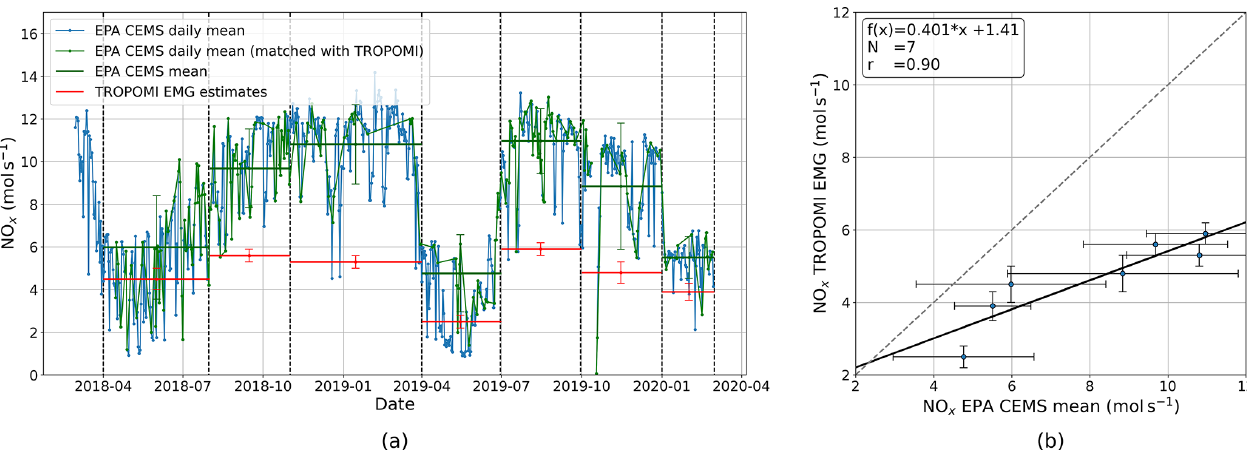
Figure 4. (a) CEMS NO x emissions for the Colstrip (Montana, USA) power plant compared to the NO x emissions estimated by the EMG method, using TROPOMI NO 2 data. CEMS data are daily mean values, averaged between 11:00 and 14:00 local time, shown in blue and filtered for days with TROPOMI measurements shown in green. Means over seven selected periods, marked by the dashed black lines, are shown by the horizontal green lines for the CEMS data and red lines for the TROPOMI EMG estimates. (b) Scatter plot of CEMS-measured NO x emissions versus TROPOMI EMG NO x emission estimates for the seven periods. The 1 : 1 line is indicated with the gray dashed line. The solid black line indicates the linear regression. Error bars are the standard deviation derived by the EMG fitting procedure for the EMG emission estimates and the monthly standard deviation for the CEMS mean